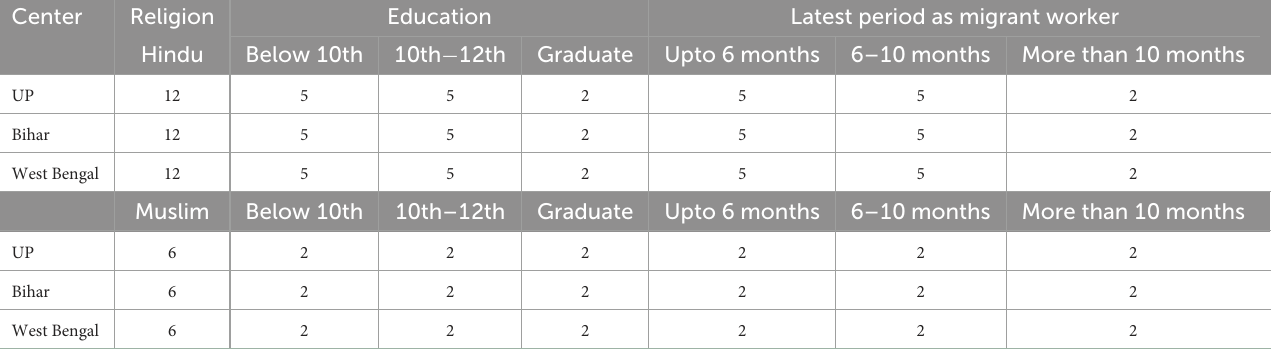
TABLE 1 Sample for the study on which the typology is based.